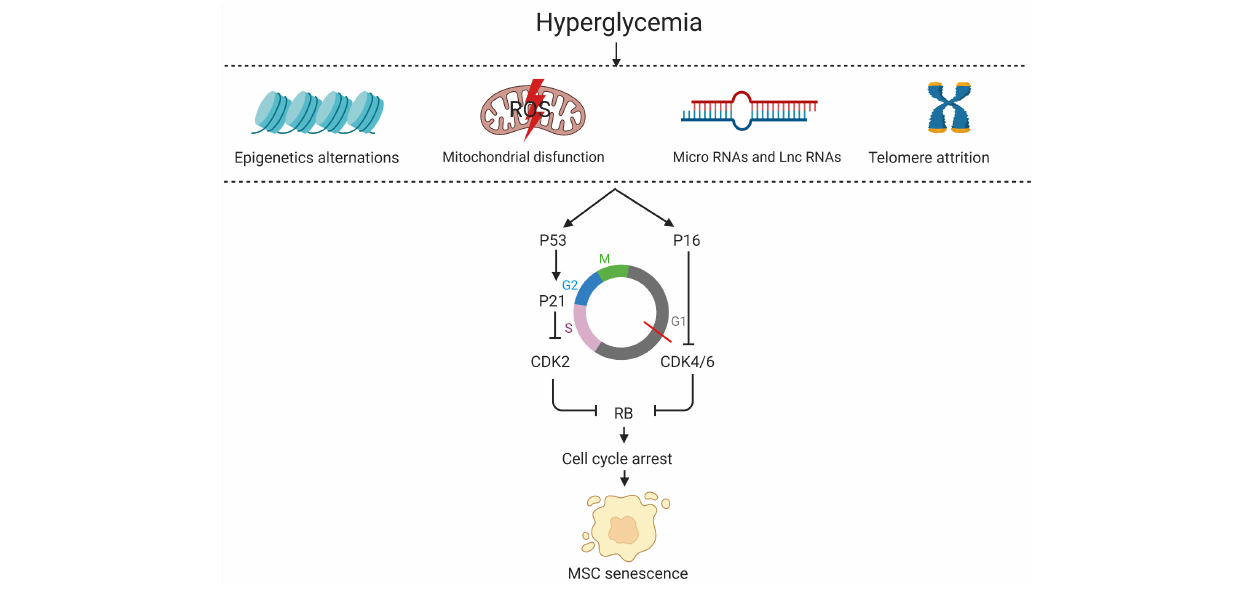
FIGURE 2 | The mechanisms of senescent MSCs in the hyperglycemic